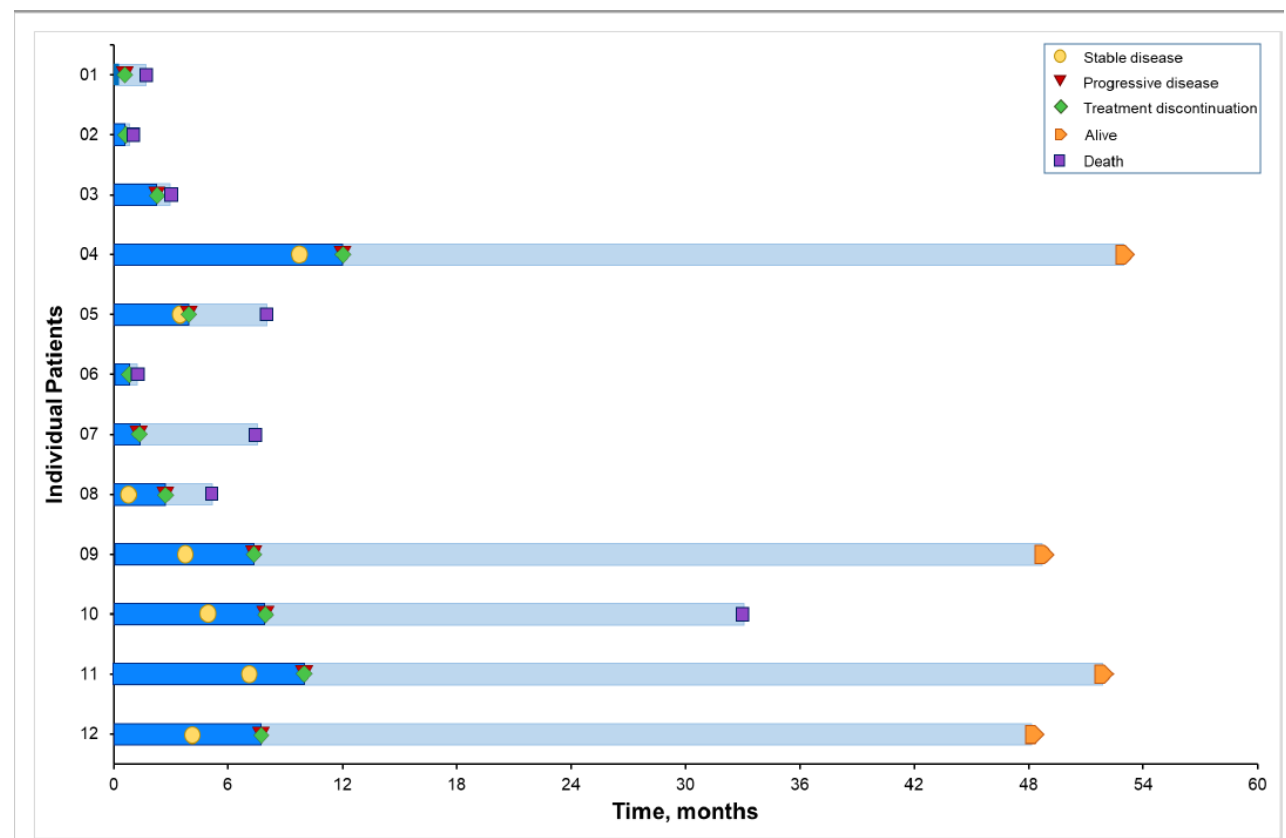
Figure 2. Swimmer plot. Clinical events in patients who underwent treatment with BBI608 and immunotherapy. The swimmer plot illustrates clinical responses in relationship to duration of treatment and time of treatment discontinuation. Cycle 1, day 1 was chosen as baseline (time 0). Symbols along and at the end of each bar represent relevant clinical events. Data cut-off, August 2021.